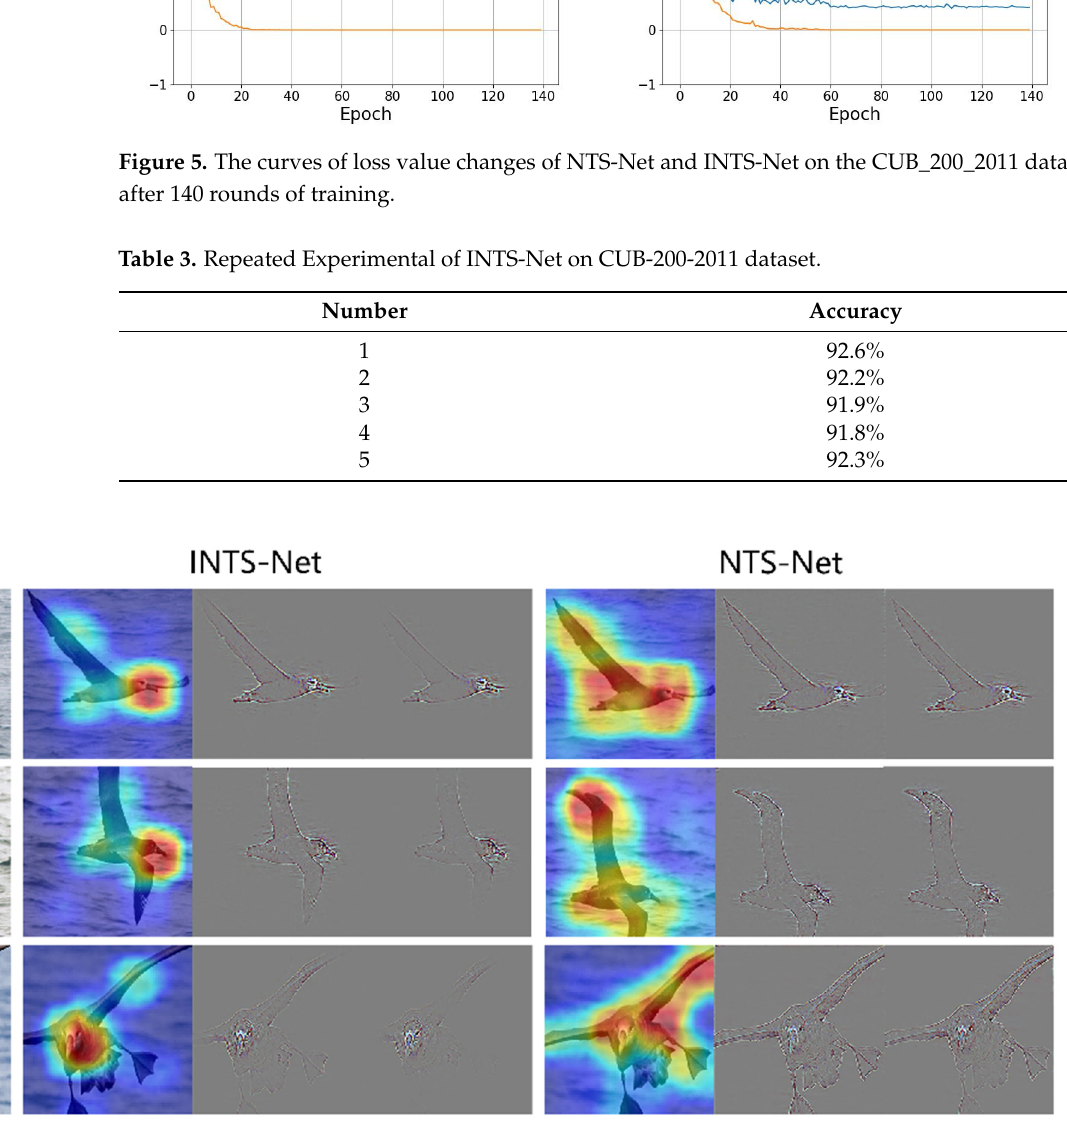
Figure 6. Visualize the features of ResNet50.